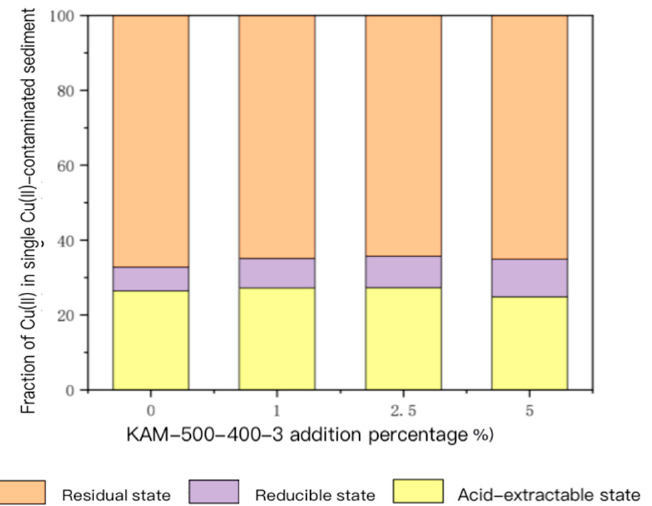
Figure 7. Fraction of Cd(II) in Cu(II)–Cd(II) mixed contaminated sediment determined through BCR sequential extraction under different addition percentages of KAM500-400-3.